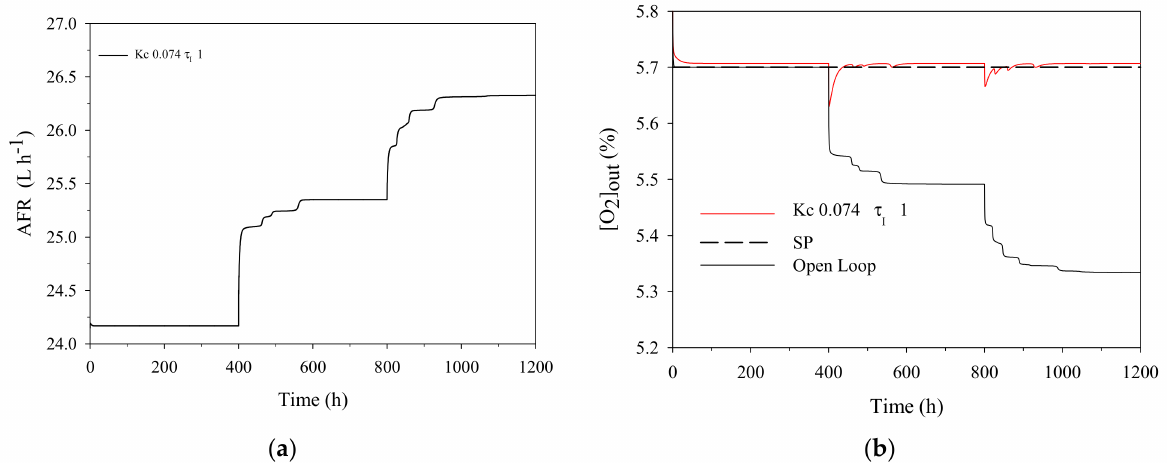
Figure 5. AFR-CL strategy results. ( a ) Air flowrate (manipulated variable) for O 2 control facing inlet H 2 S concentration changes using a PI controller showing stable behavior and ( b ) O 2 concentration (controlled variable) for O 2 control facing inlet H 2 S concentration changes using a PI controller showing stable behavior.